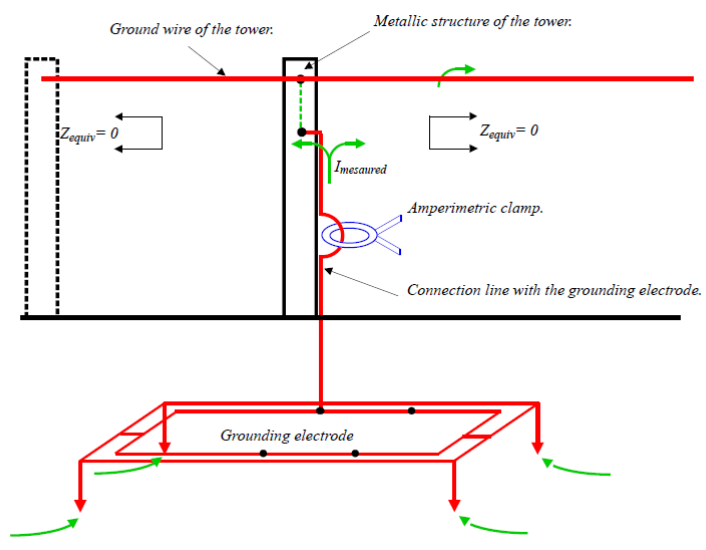
Figure 6. Measurement of the grounding resistance by means of the clamp-on method.